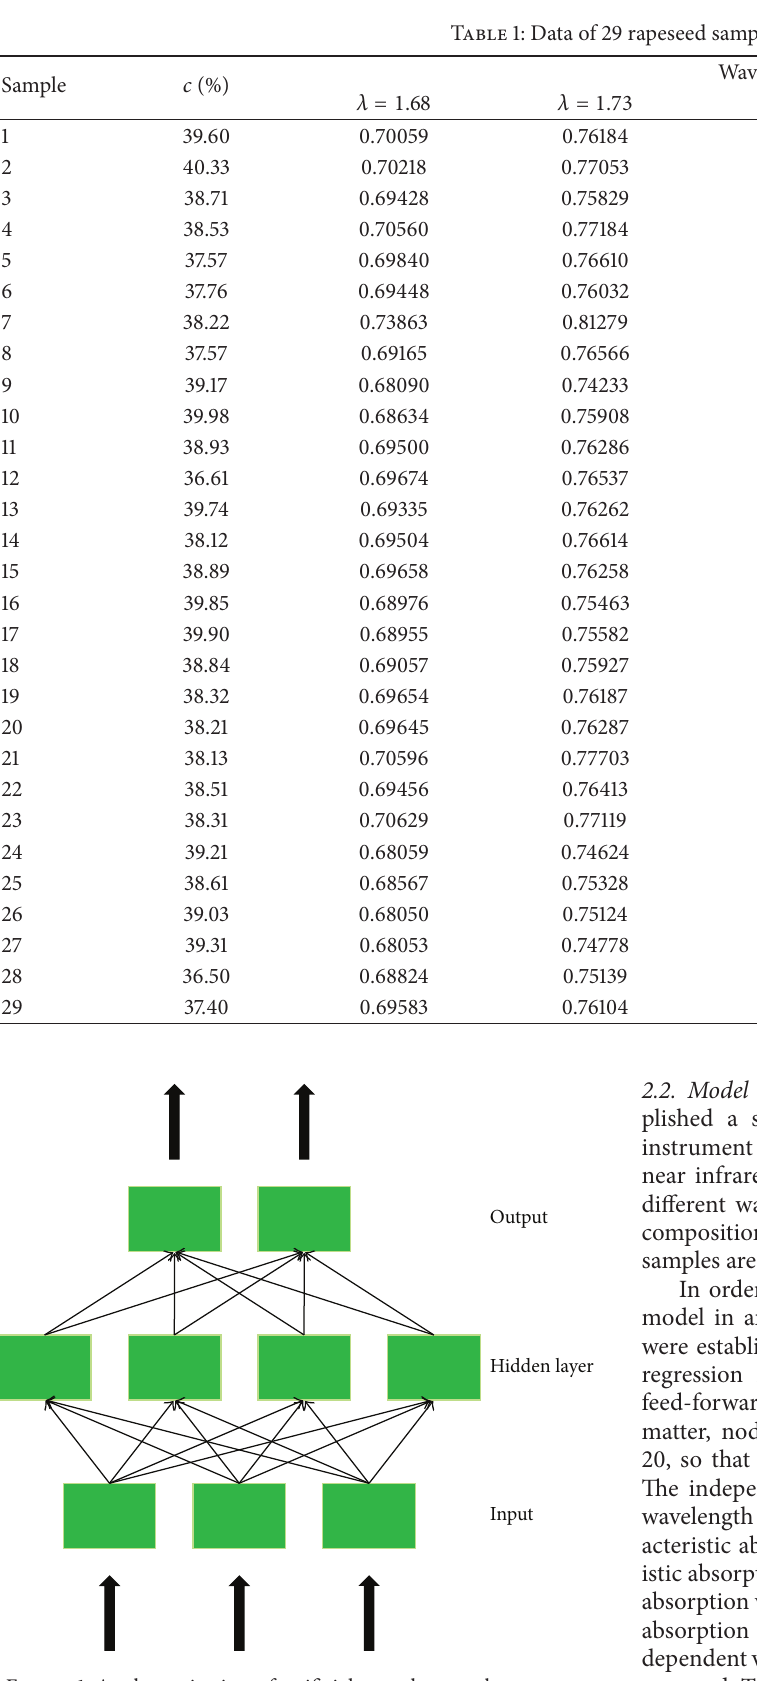
Figure 1: A schematic view of artificial neural network